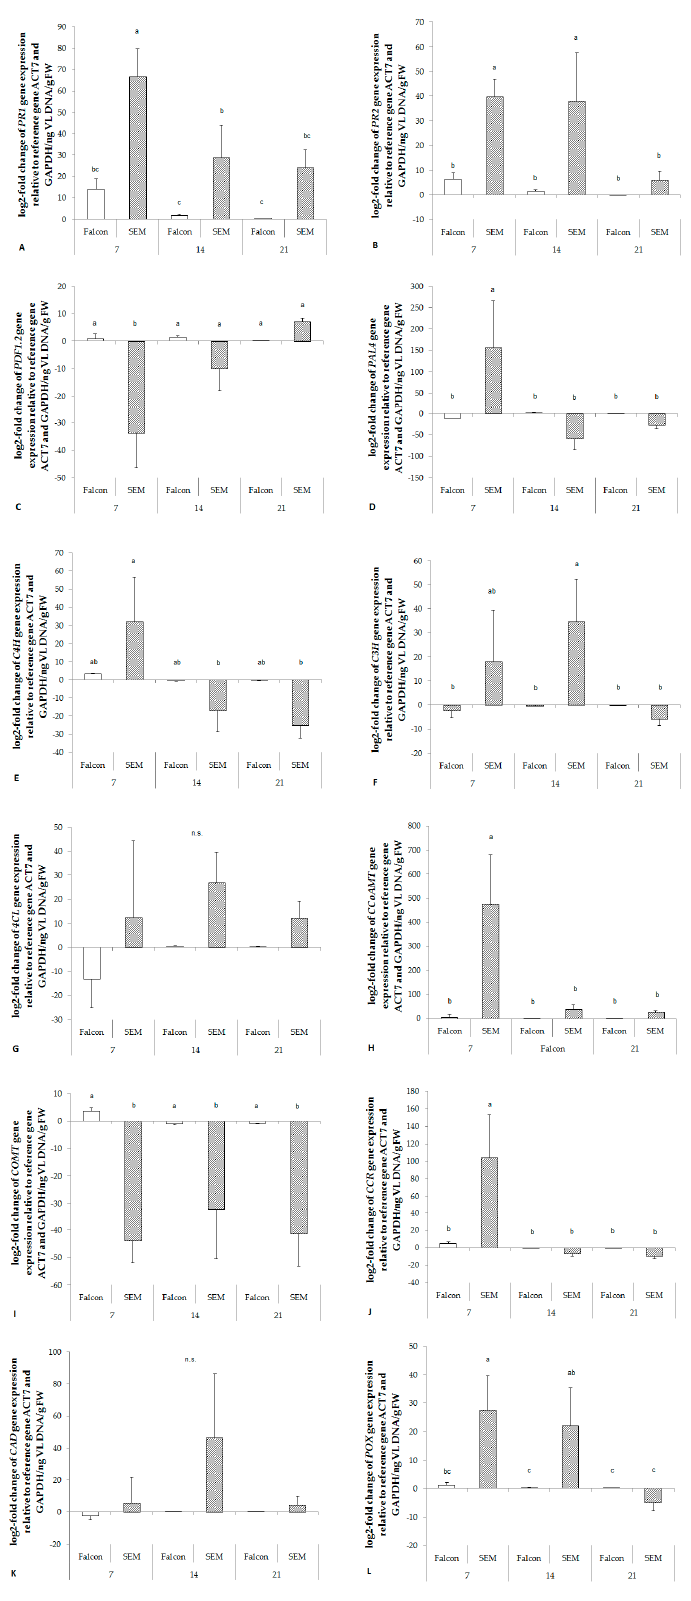
Figure 5. Fold change of salicylic acid mediated resistance marker genes ( A, B ), jasmonic acid mediated resistance marker gene ( C ), and genes of key enzymes involved in lignin synthesis ( D–L ) in the hypocotyl of B. napus after infection by V. longisporum . The change rates were derived from a comparison of mock-inoculated plants. Target gene expression was normalized to the expression of ACT7 and GAPDH